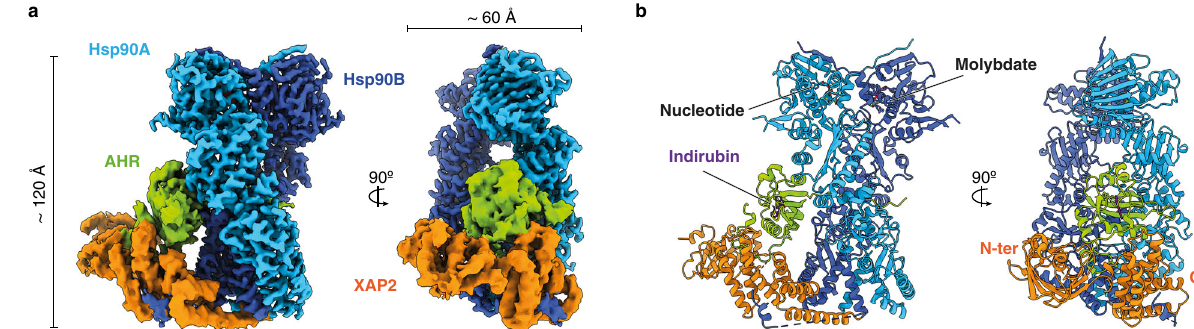
Fig.1|Overallarchitectureoftheagonist-boundcytosoliccomplexofAHR.a A compositemapoftheHsp90-XAP2-AHRcomplexintwoorthogonalviews.Hsp90A (light blue), Hsp90B (dark blue), XAP2 (orange), AHR (green). The same colour scheme is used throughout the manuscript unless stated otherwise. b The atomic